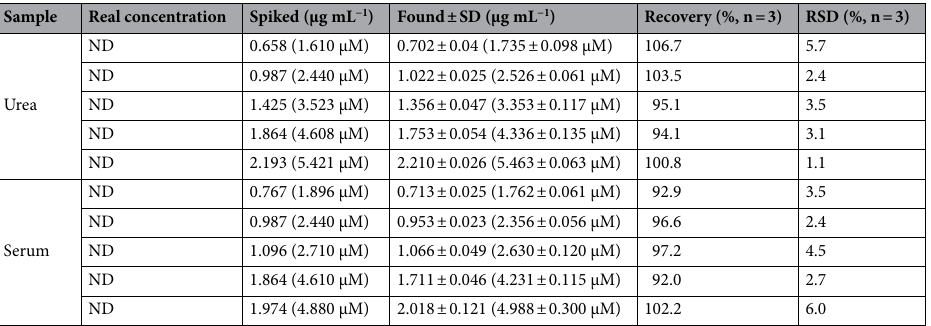
Table 2. Results for determination of TMS in real